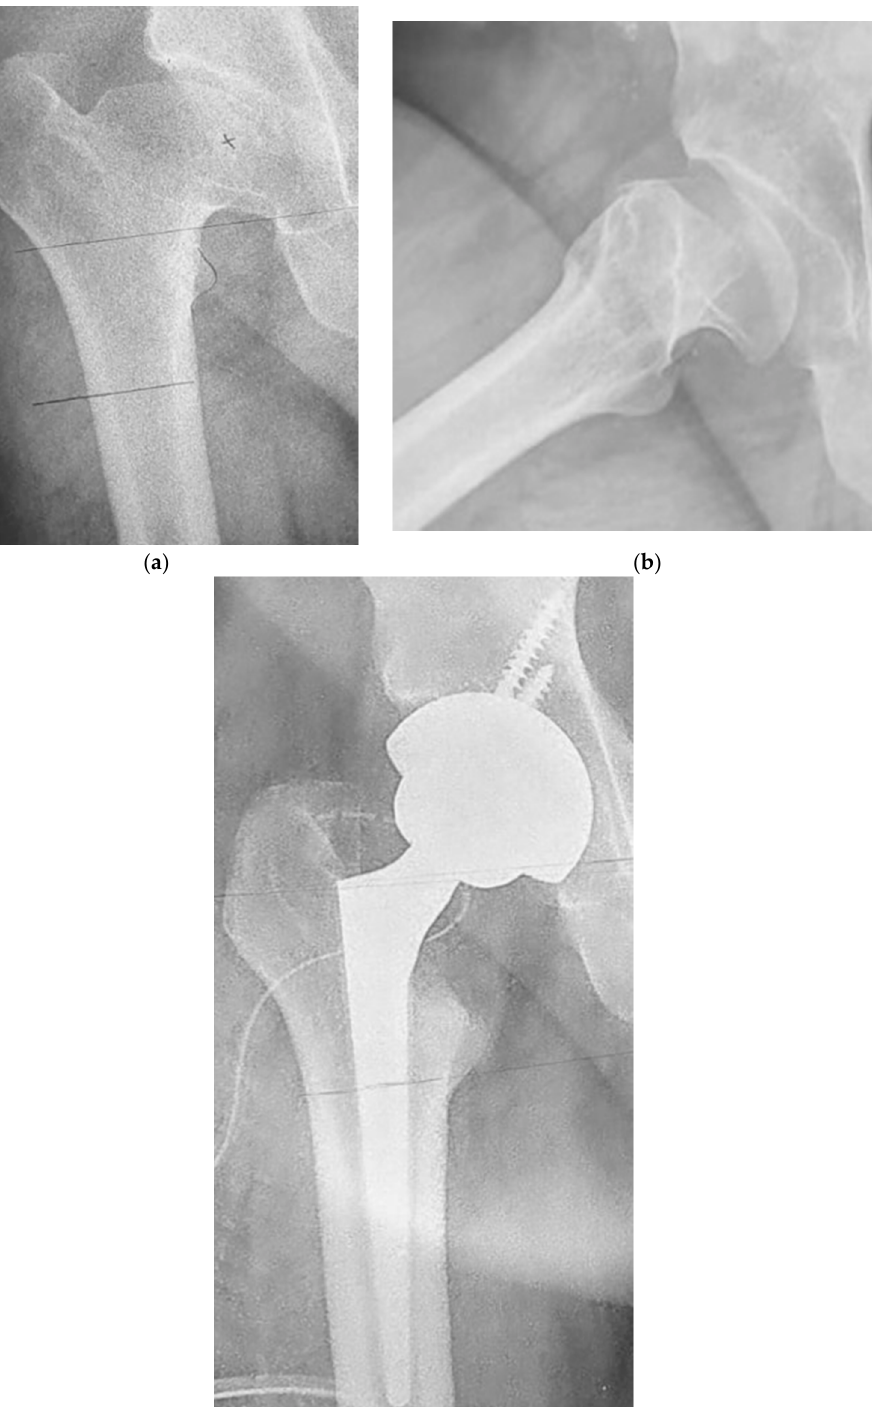
Figure 2. Male, 55 years old, right hip osteoarthritis secondary to development dysplasia: preoperative AP and axial radiographs ( a , b ), and postoperative X-ray ( c ) of the AMC-on-AMC THA using screws for implementation of cup fixation and a conical stem below it.